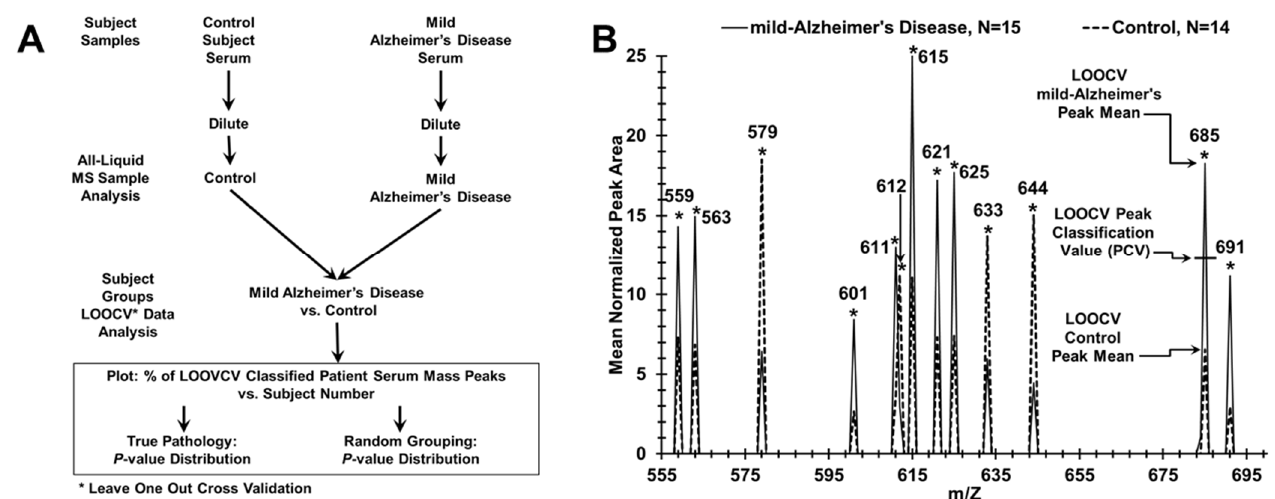
Figure 1. Analytical procedures involving LOOCV/PCV for distinguishing AD patient and control groups using a MS serum profiling platform. ( A ) Flow chart for serum sample handling and mass spectrometry for binary AD patient/subject group analysis. ( B ) Serum mass peak Scoring for LOOCV/PCV (leave [one serum sample] out cross validation/peak classification value) procedure to classify mass peaks as either “mild AD” or control from a “left out” sample, over a narrow range (555–695 m / z is displayed) of significant group discriminatory mass peaks. The PCV example is exhibited on peak 685 which is used to classify “left out” peaks as either “mild AD” (peak area above this PCV) or control (peak area at or below this PCV).